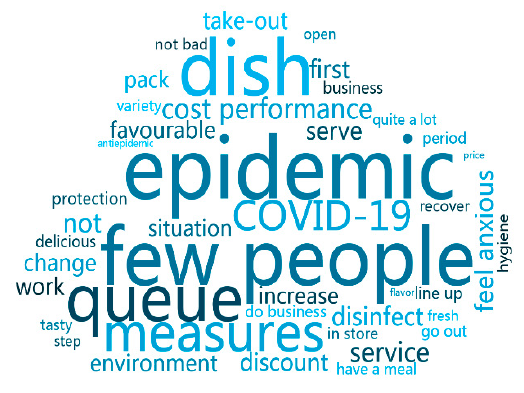
Figure 3. Word cloud after COVID-19.